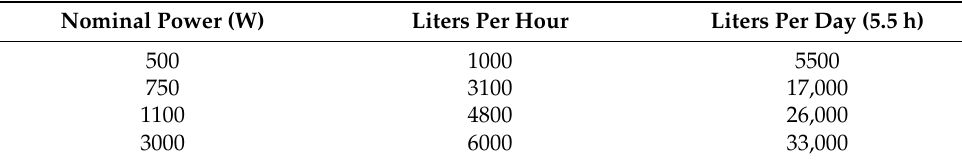
Table 1. Typical nominal power of solar-powered DC borehole pumps